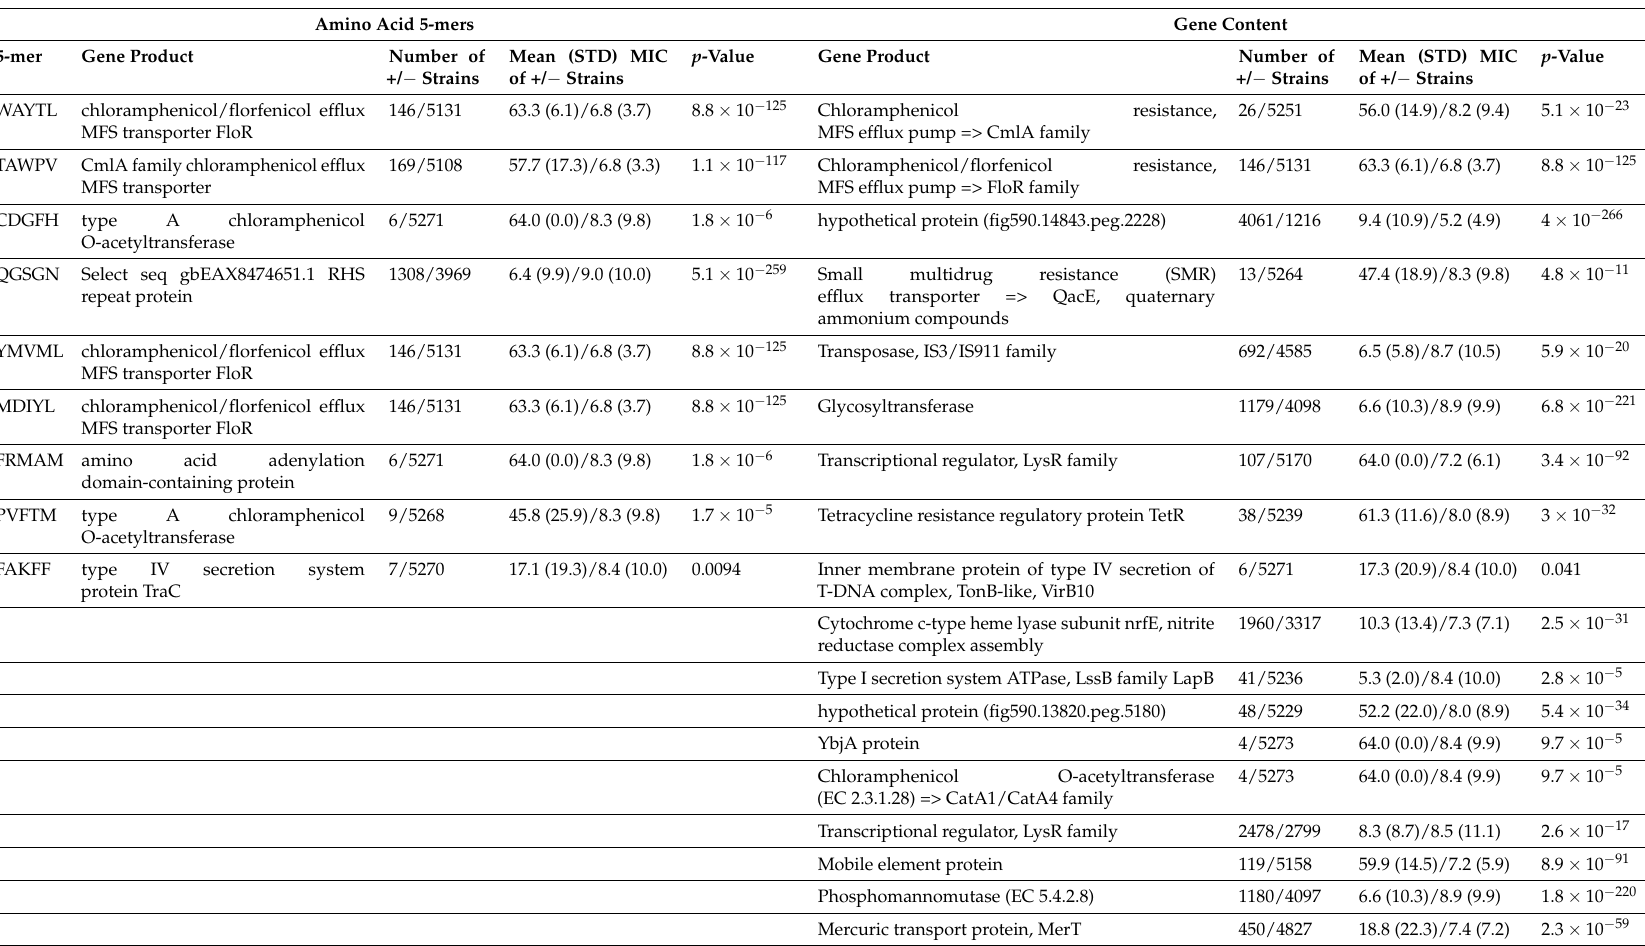
Table A10. Important genes found for S. enterica and chloramphenicol by amino acid 5-mer and gene content